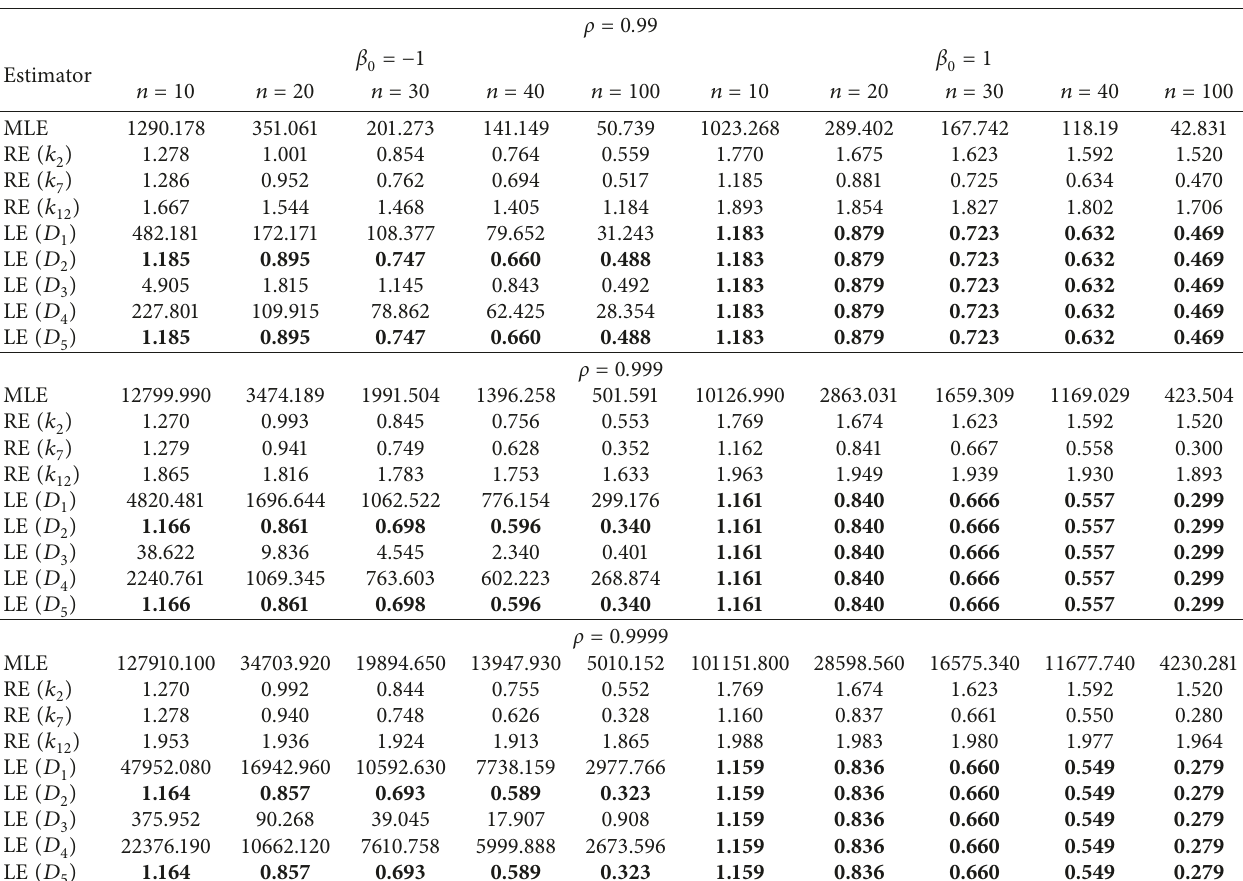
Table 8: Estimated SMSE values for different n, ρ ,k, d, and β